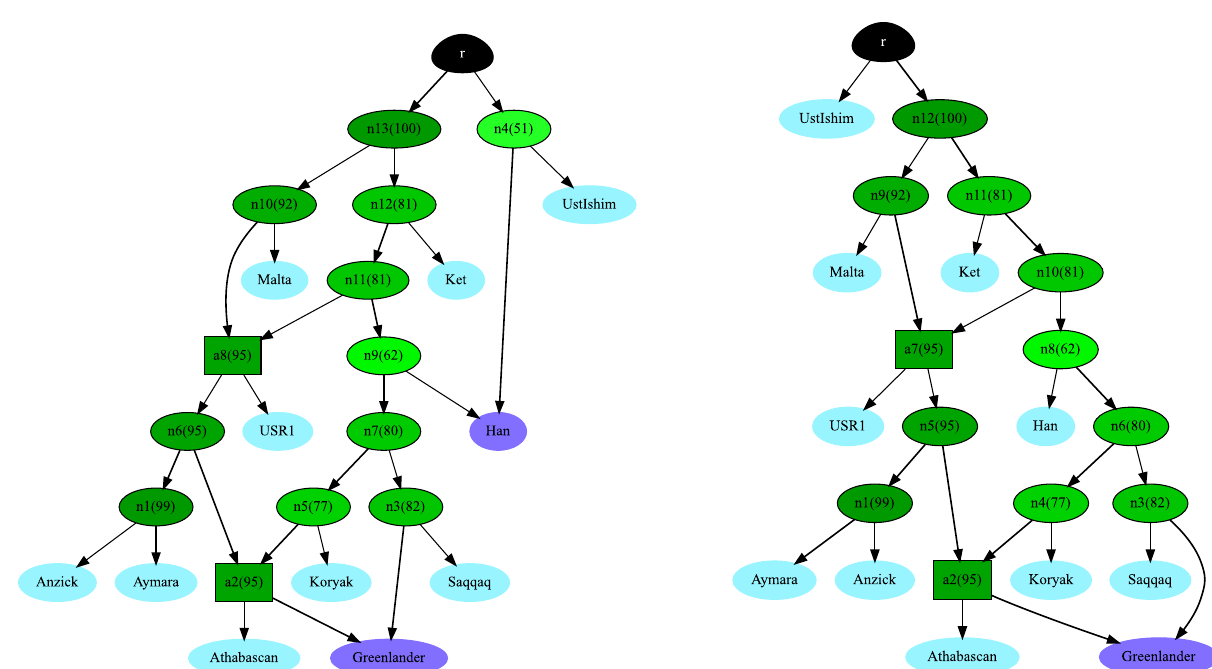
Fig 3. The two minimal topologies with the highest posterior probabilities in our real dataset. Leaf nodes that are the product of an admixture event are shown in purple. Leaf nodes that are not the product of an admixture event are shown in light blue. The root is shown in black. Each inner node is colored according to the posterior probability that the true graph has a node with the same descendants. Higher probabilities have a darker shade of green. The posterior probability is written as a percentage in parentheses inside each node, next to the node name, which is arbitrary. The left graph has a posterior probability of 32%. The right graph has a posterior probability of